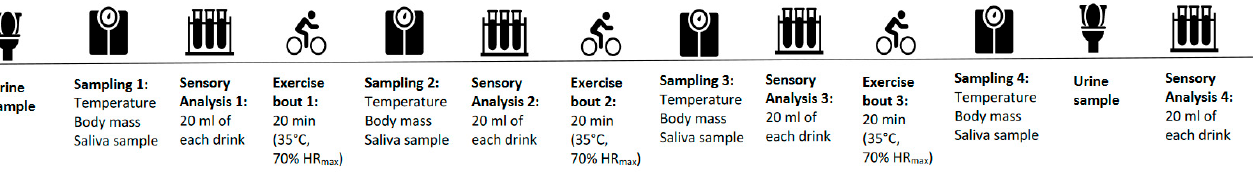
Figure 1. Overview of the exercise and sensory protocol comprised 3 × 20-min bouts of cycling exercise in a warm room (30–35 °C) at a moderate intensity (70–80% HR max ). Three drinks: an oral rehydration solution (ORS), a beverage formulation based on a traditional sports drink (TS), and a flavored water placebo (PL) were evaluated for liking of saltiness, sweetness, thirst-quenching ability, and overall liking on 9-point scales before and after each 20-min exercise bout. Urine samples were collected before the 60 min of exercise; and saliva samples, aural temperature, and semi-nude body mass were assessed before and after each 20-min exercise bout. Each sensory analysis and sampling was completed within 10 min prior to the subsequent exercise bout.